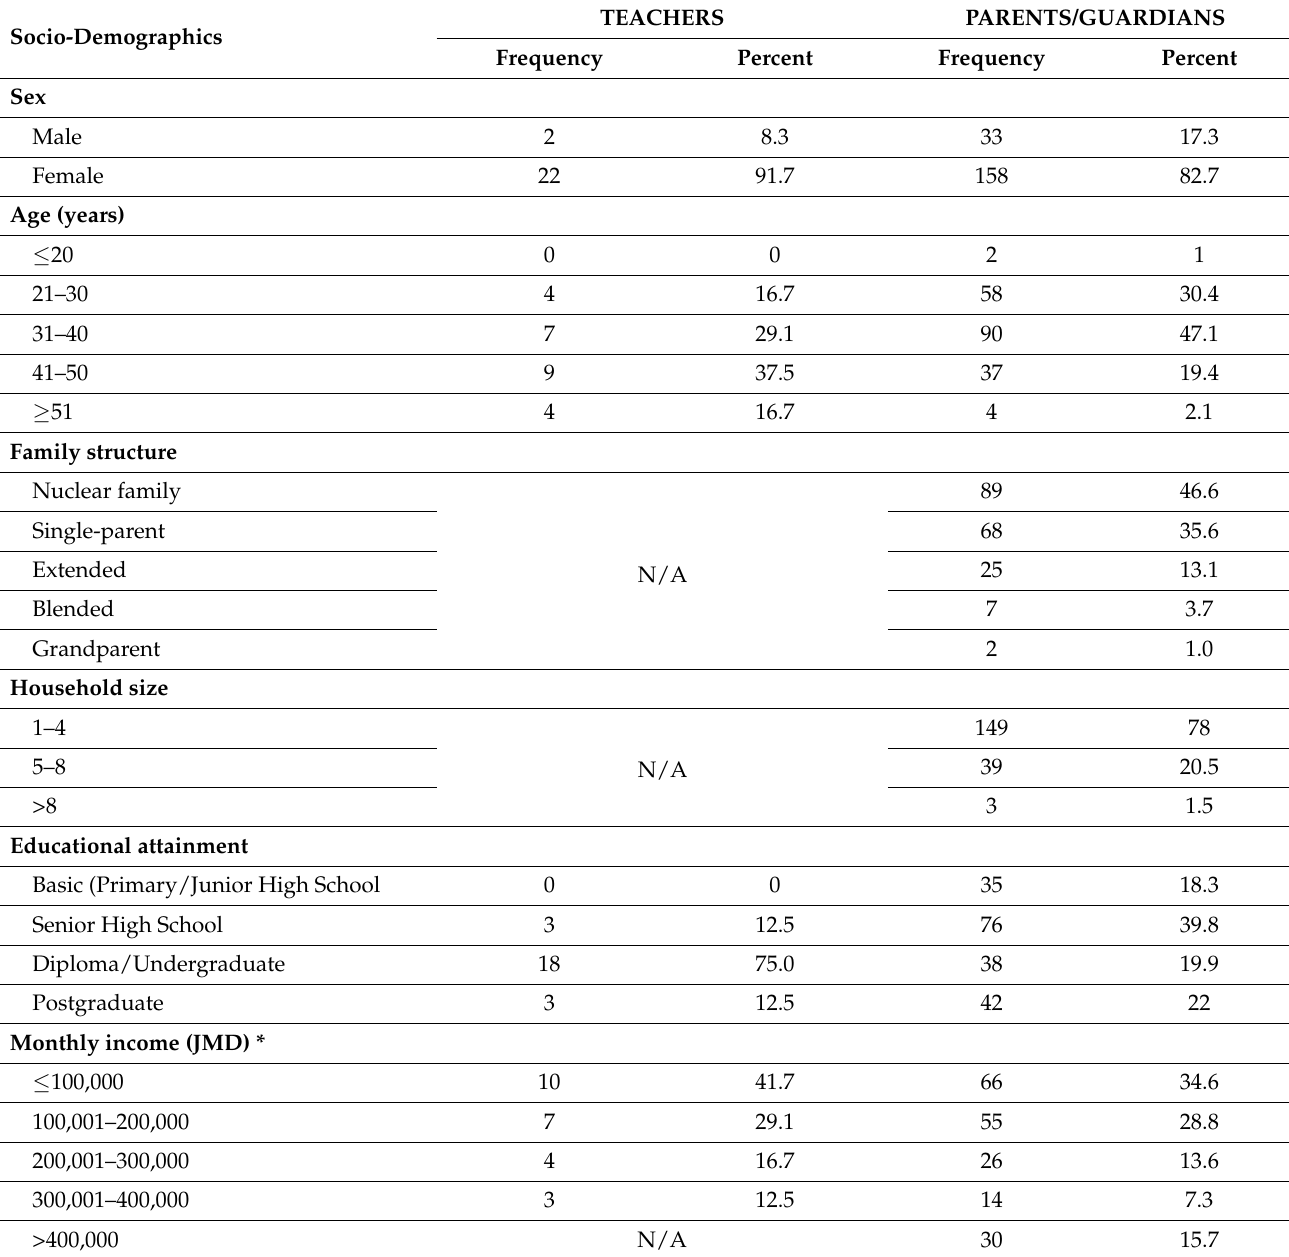
Table 1. Socio-demographic characteristics of